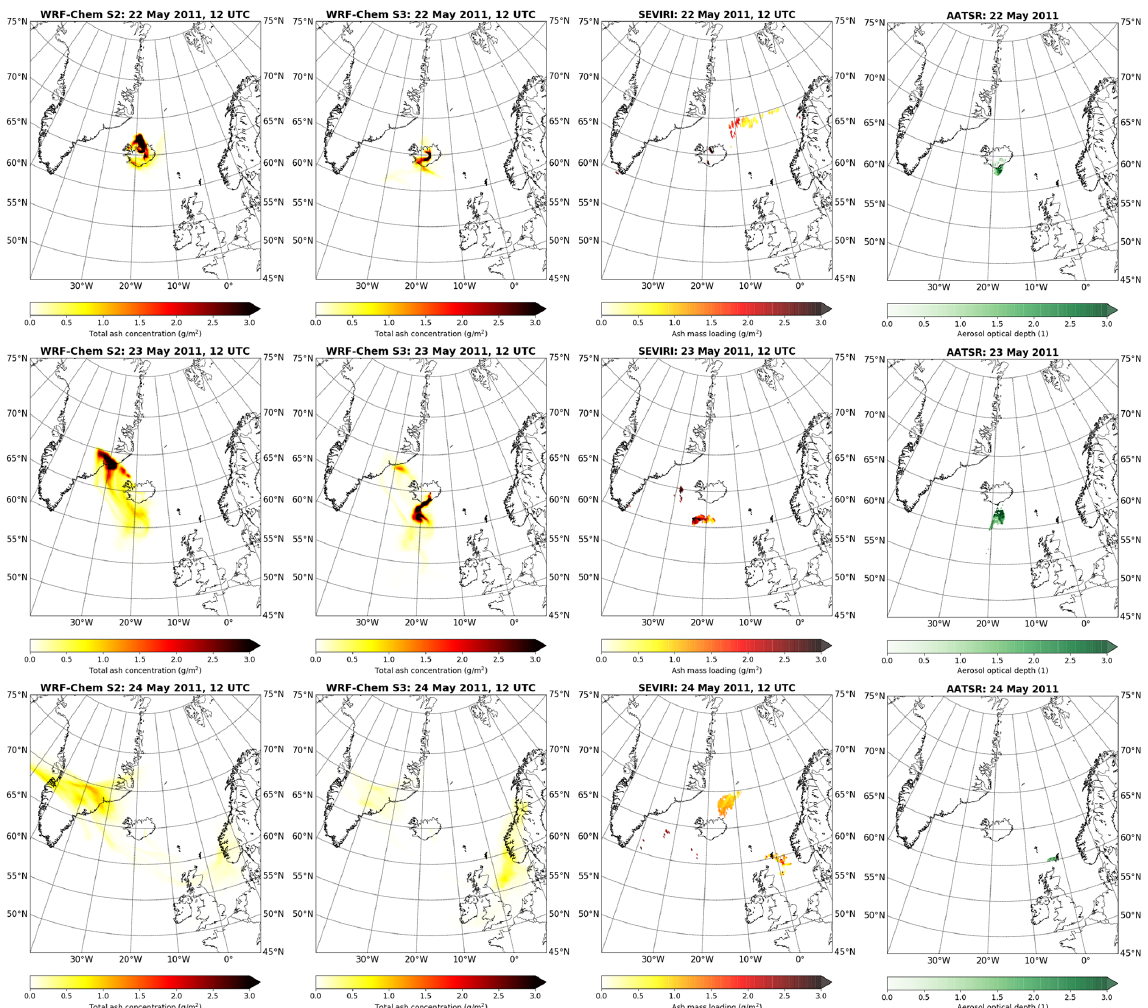
Figure A1. Total ash columns from WRF-Chem simulations (S2 and S3), SEVIRI ash mass loading, and AOT from AATSR on 22 to 24 May 2011